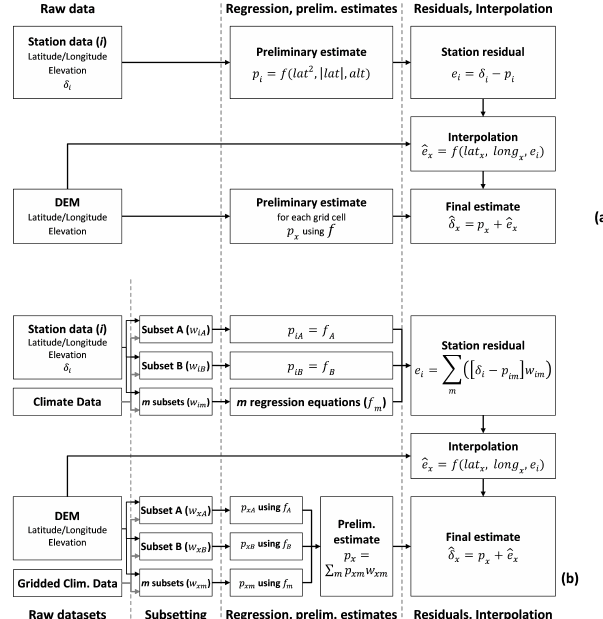
Fig. 2. Workflow of the regression-interpolation models for predicting the isotopic composition of precipitation around the globe. The upper panel (a) shows the workflow of the fixed regressor, global domain Model M1 (Bowen and Wilkinson, 2003). The lower panel (b) shows the workflow of RCWIP with the addition of climate data, regionalization and the use of flexible regressors (Models M2–M4).